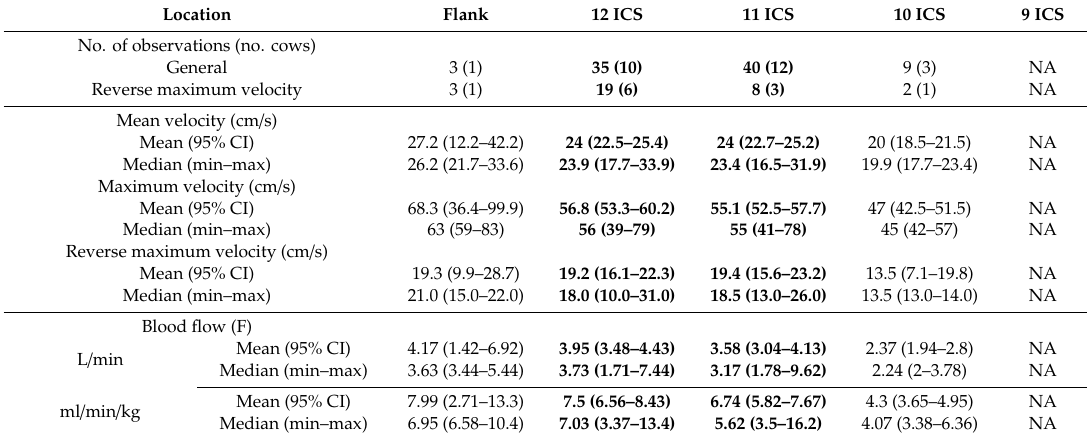
Table 2. Results of ultrasonography examination of the splenic vein expressed as mean (95% CI) and median (minimum – maximum). Values obtained in the most frequent location are highlighted in bold. Location Flank 12 ICS 11 ICS 10 ICS No. of observations (no. cows) General